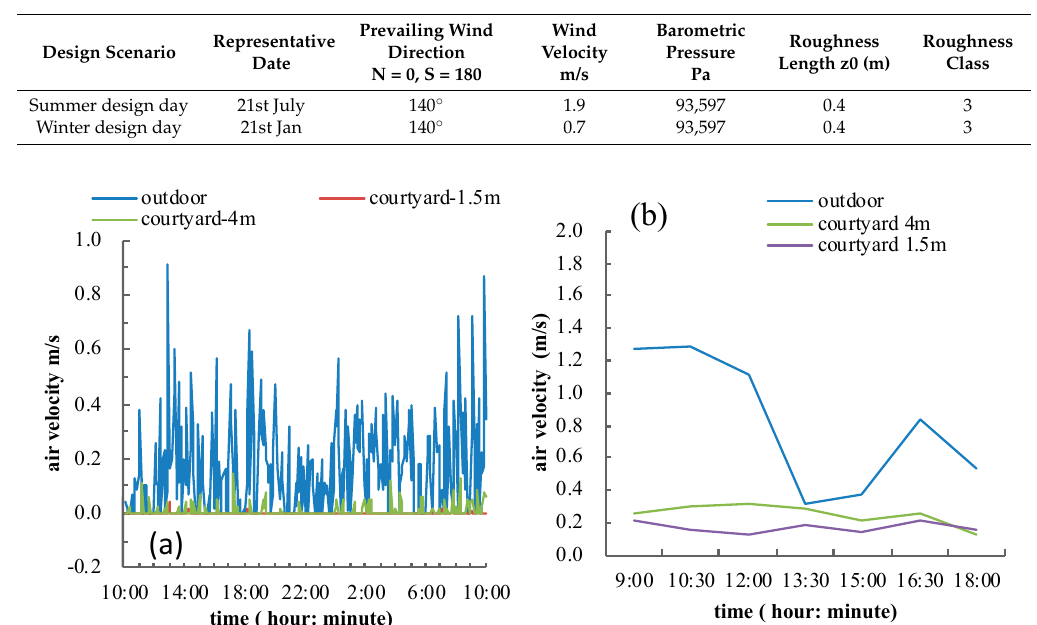
Table 3. Wind Profile Calculation Parameters.